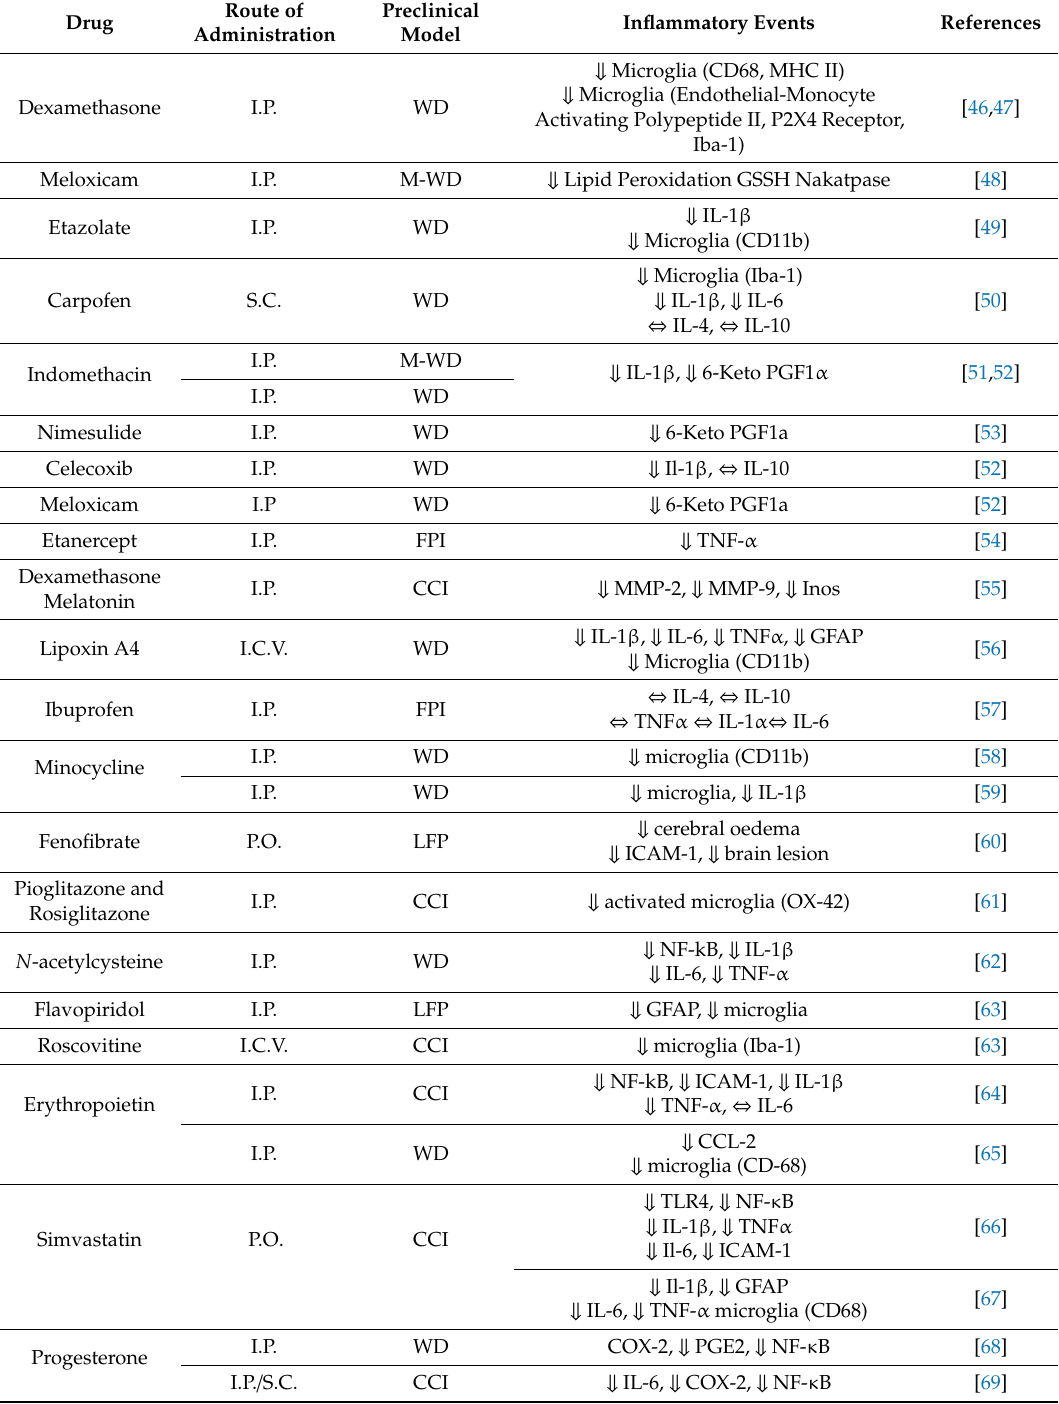
Table 3. Therapeutic drugs with anti-inflammatory action for